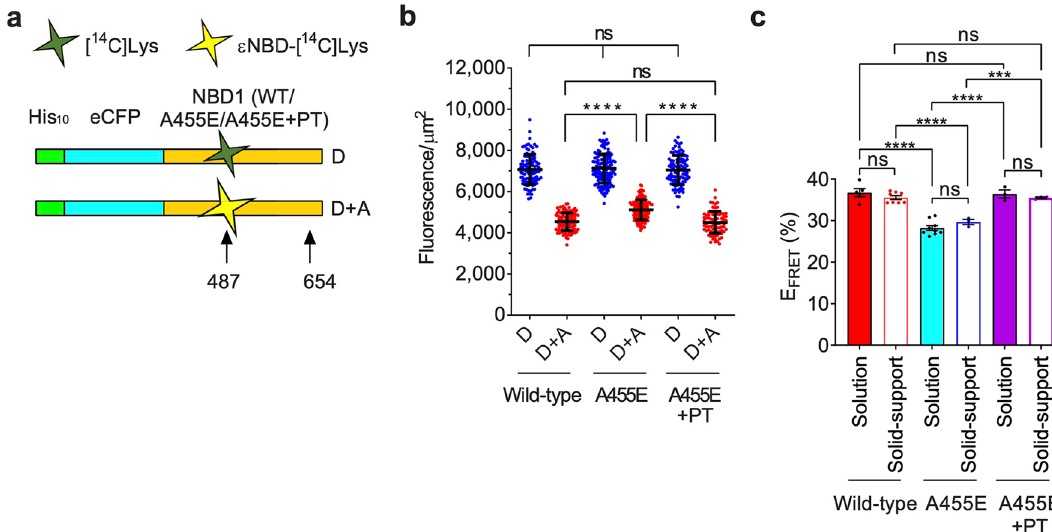
Figure 4. FRET analysis of wild-type or A455E NBD1 folding. ( a ) Schematic of His 10- CFP-NBD1 (wild-type/ A455E/A455E + PT) constructs showing approximate location of acceptor dye and truncation residues 487 and 654, respectively. ( b ) Graph showing fluorescence intensity of individual D or D + A beads for wild-type, A455E, or A455E + PT constructs (acceptor at 487 and truncation at 654) obtained from individual experiments in 384-well format (mean ± SD, n = 81–142 beads). ( c ) Graph showing E FRET values obtained from individual experiments of solution or solid-support FRET assay in 384-well format for wild-type, A455E, or A455E +